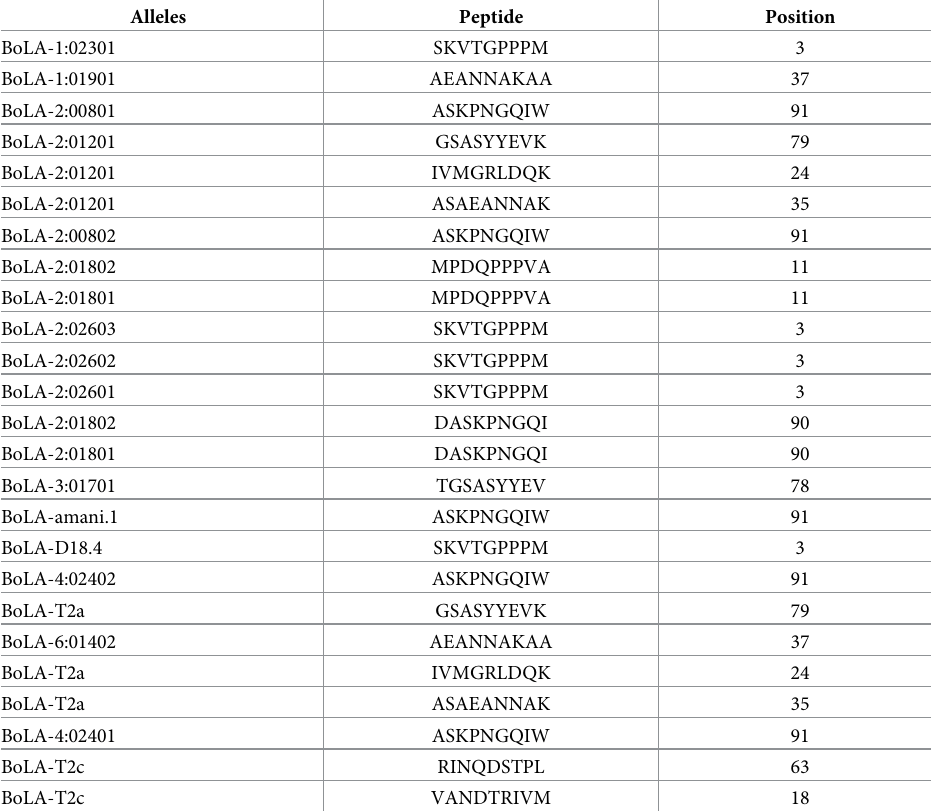
Table 3. ht-FAP-P CTL epitopes with highest score. Alleles